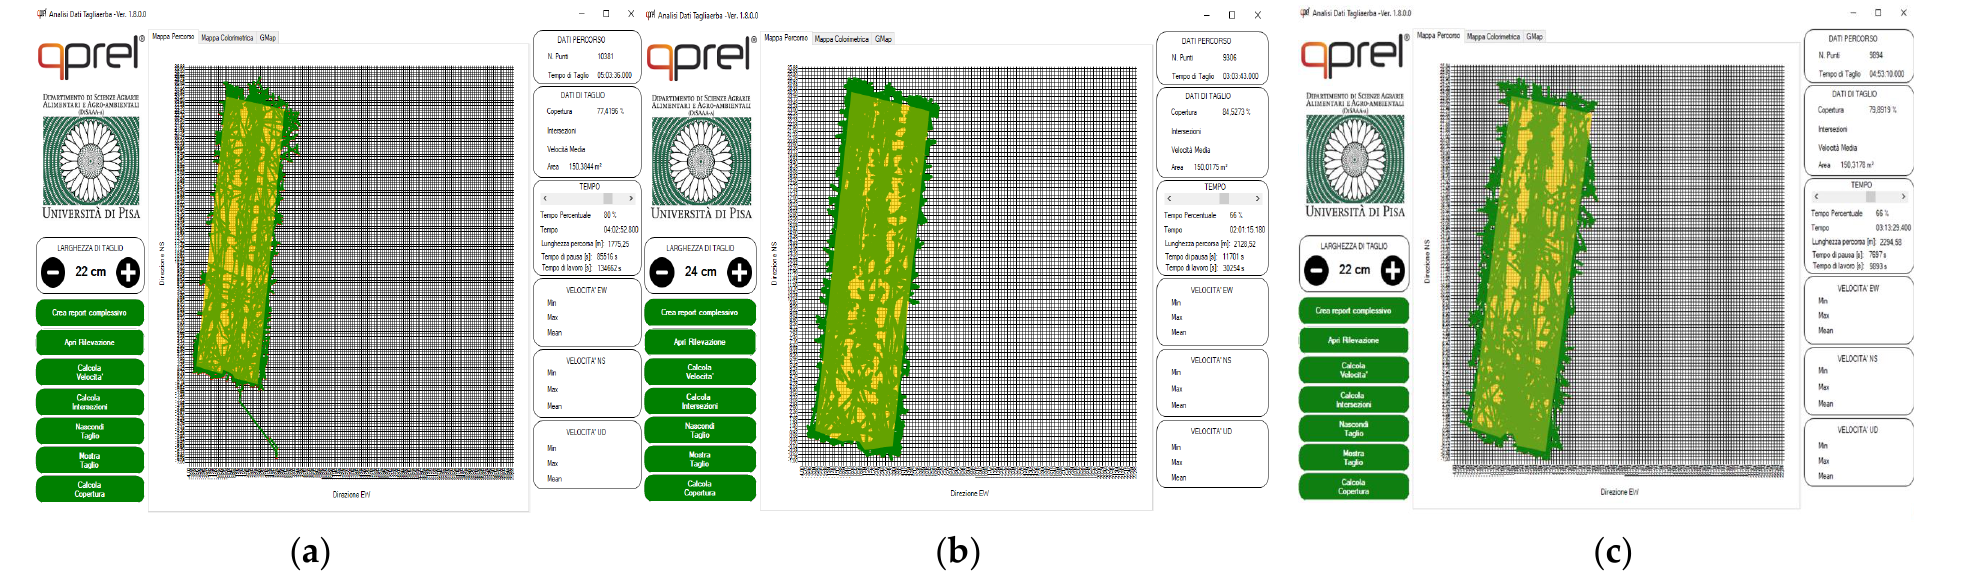
Figure 4. Screens of the “Robot mower tracking data calculator” software displaying the mowed area after 3 h of work by ( a ) AM1, ( b ) AM2 and ( c )